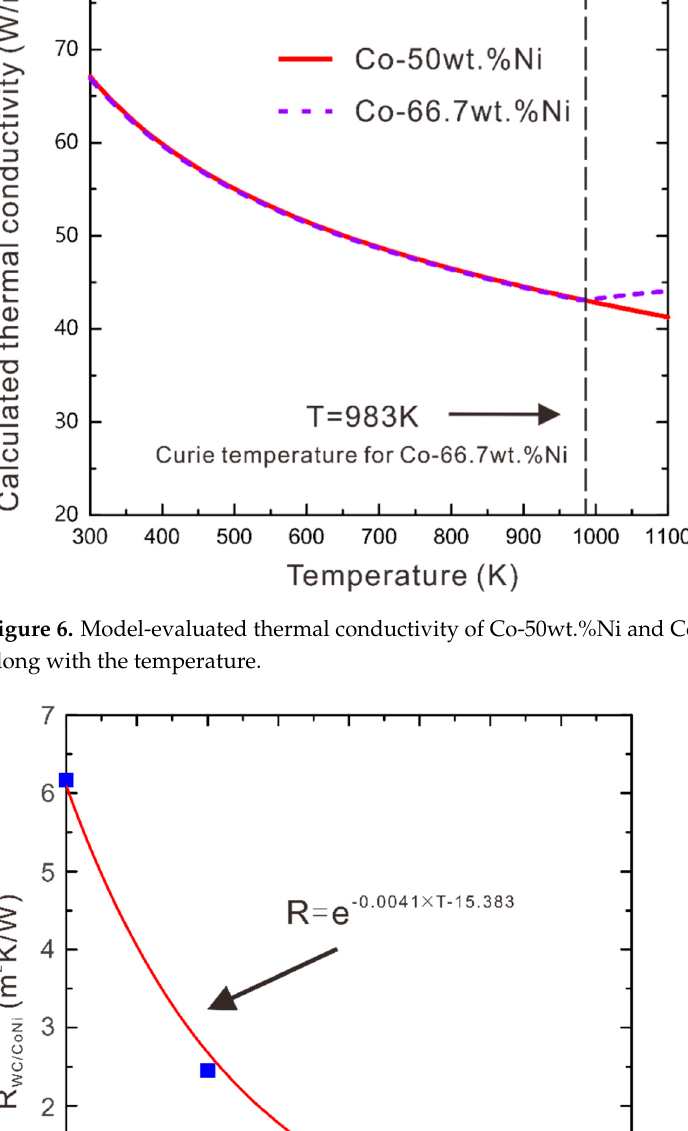
Table 2. The evaluated parameters in Equations (6) and (7).